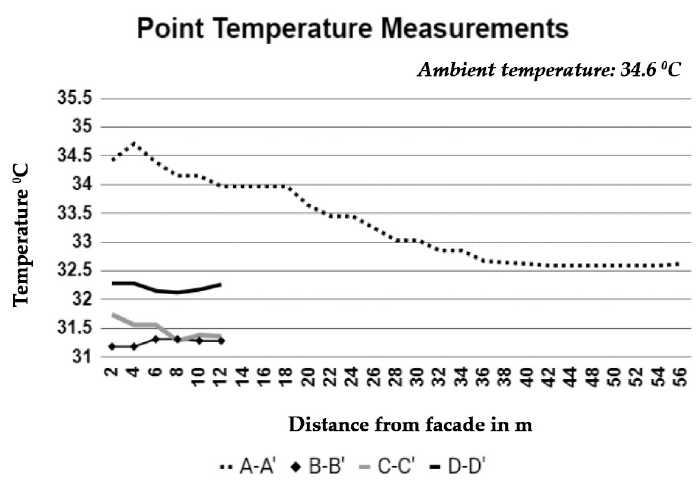
Figure 5. Multizone air temperature behavior in this air conditioned Building “B”- move between 31.5 and 34.7 °C despite set point temperature at 24 °C; BEI is around 120 k/Whm 2 /a, but high risk of heat gain is visible.